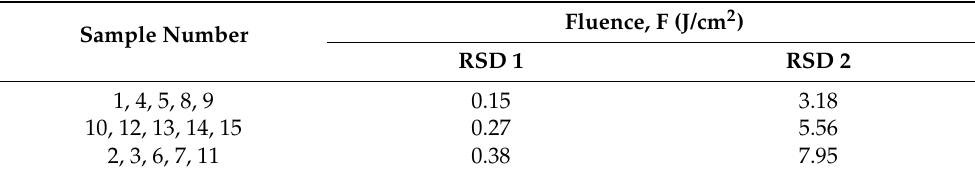
Table 5. Fluence values corresponding to the three levels of the experimental analysis.